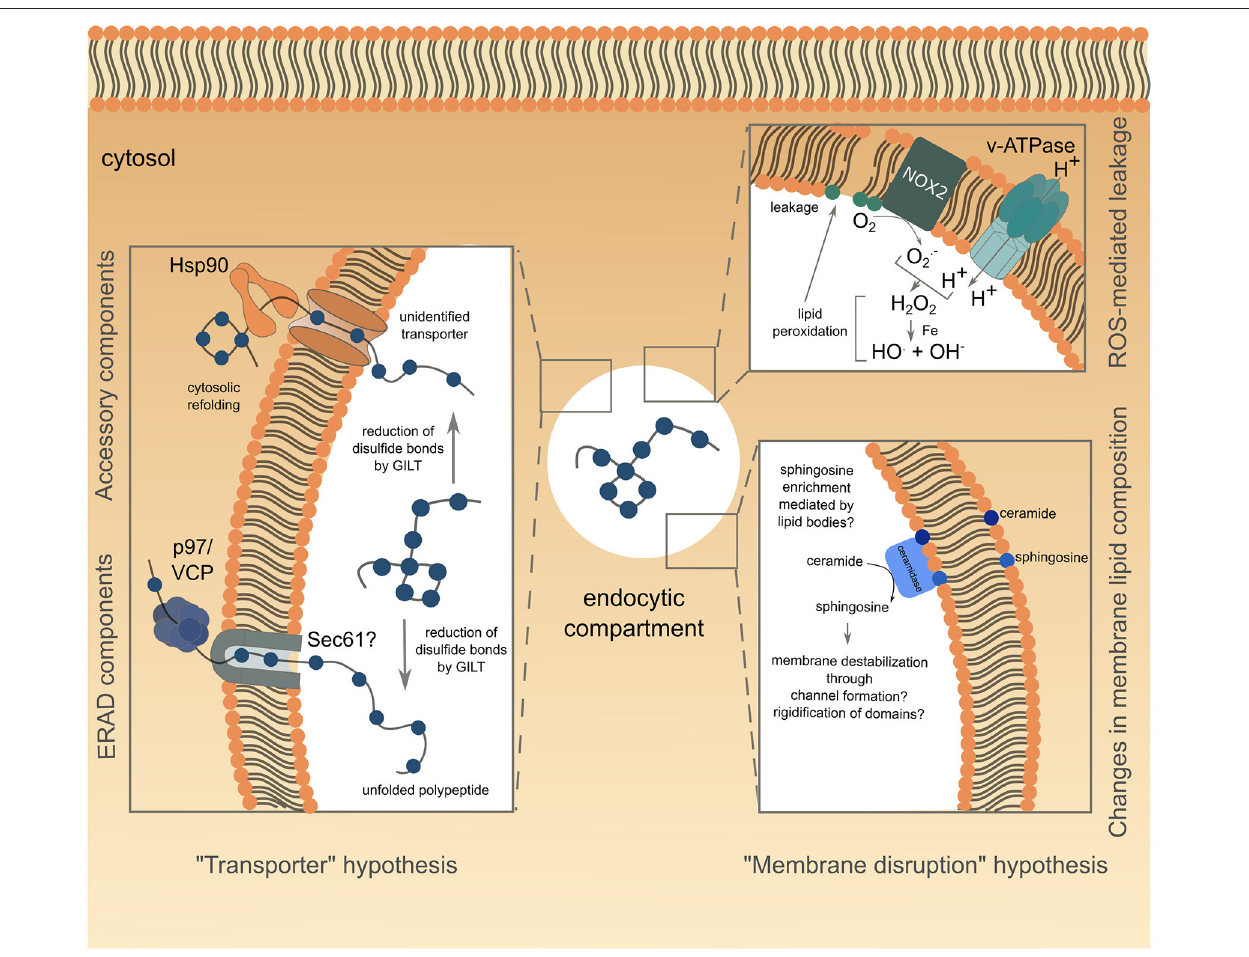
FIGURE 1 | Schematic representation of the current understanding of antigen export to the cytosol during cross-presentation. The transporter hypothesis is depicted on the left side of the figure, with complexes involved grouped according to known (for ERAD) or supposed (Hsp90 with unknown transporter) interactions. The alternative membrane disruption hypothesis is depicted on the right side of the figure. The ROS-mediated leakage part has been confirmed experimentally, while modification of endo/phagosome lipid composition, suggested by biophysical studies, is speculative and lacks functional relevance in antigen export to the